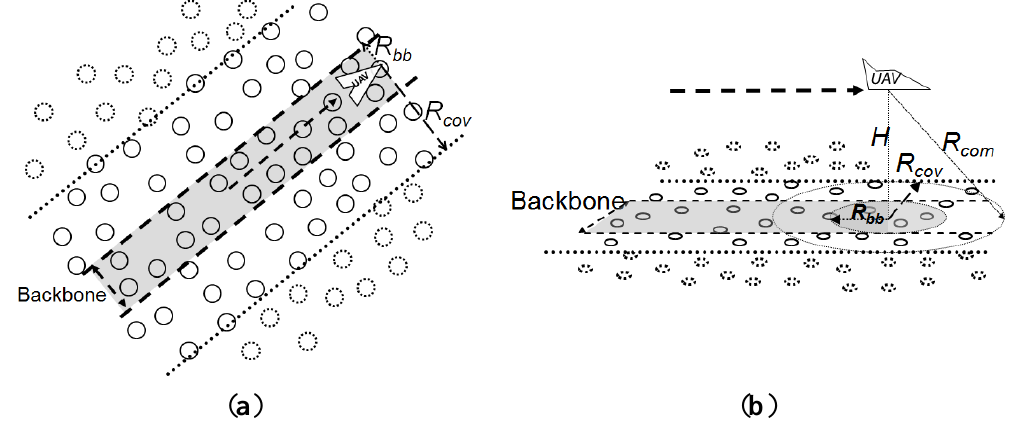
8. Pheromone trail with backbone: ( a ) Top-down 2 dimensional view; ( b ) 3 dimensional